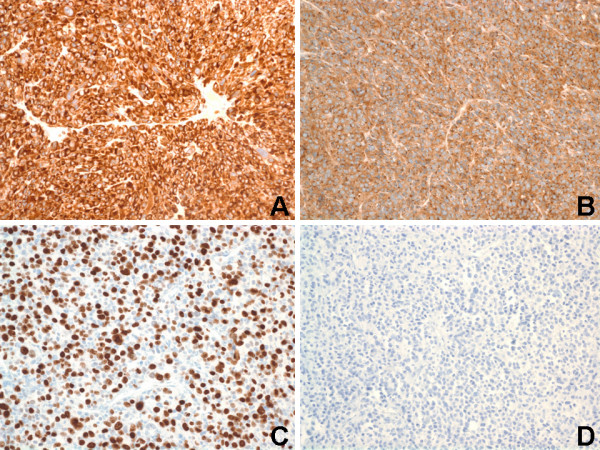
Immunohistochemical staining of renal tumor. (A) Tumor cells showed strong and diffusely reactivity for BCL-2 (Immunoperoxidase, Original magnification ×200). (B) Tumor cells showed strong and diffusely reactivity for CD99 (Immunoperoxidase, Original magnification ×200). (C) Ki67 immunostaining showed a proliferative index of 70% (Immunoperoxidase, Original magnification ×200). (D) Tumor cells showed negative reactivity for renal cell carcinoma marker (RCC) (Immunoperoxidase, Original magnification ×200).